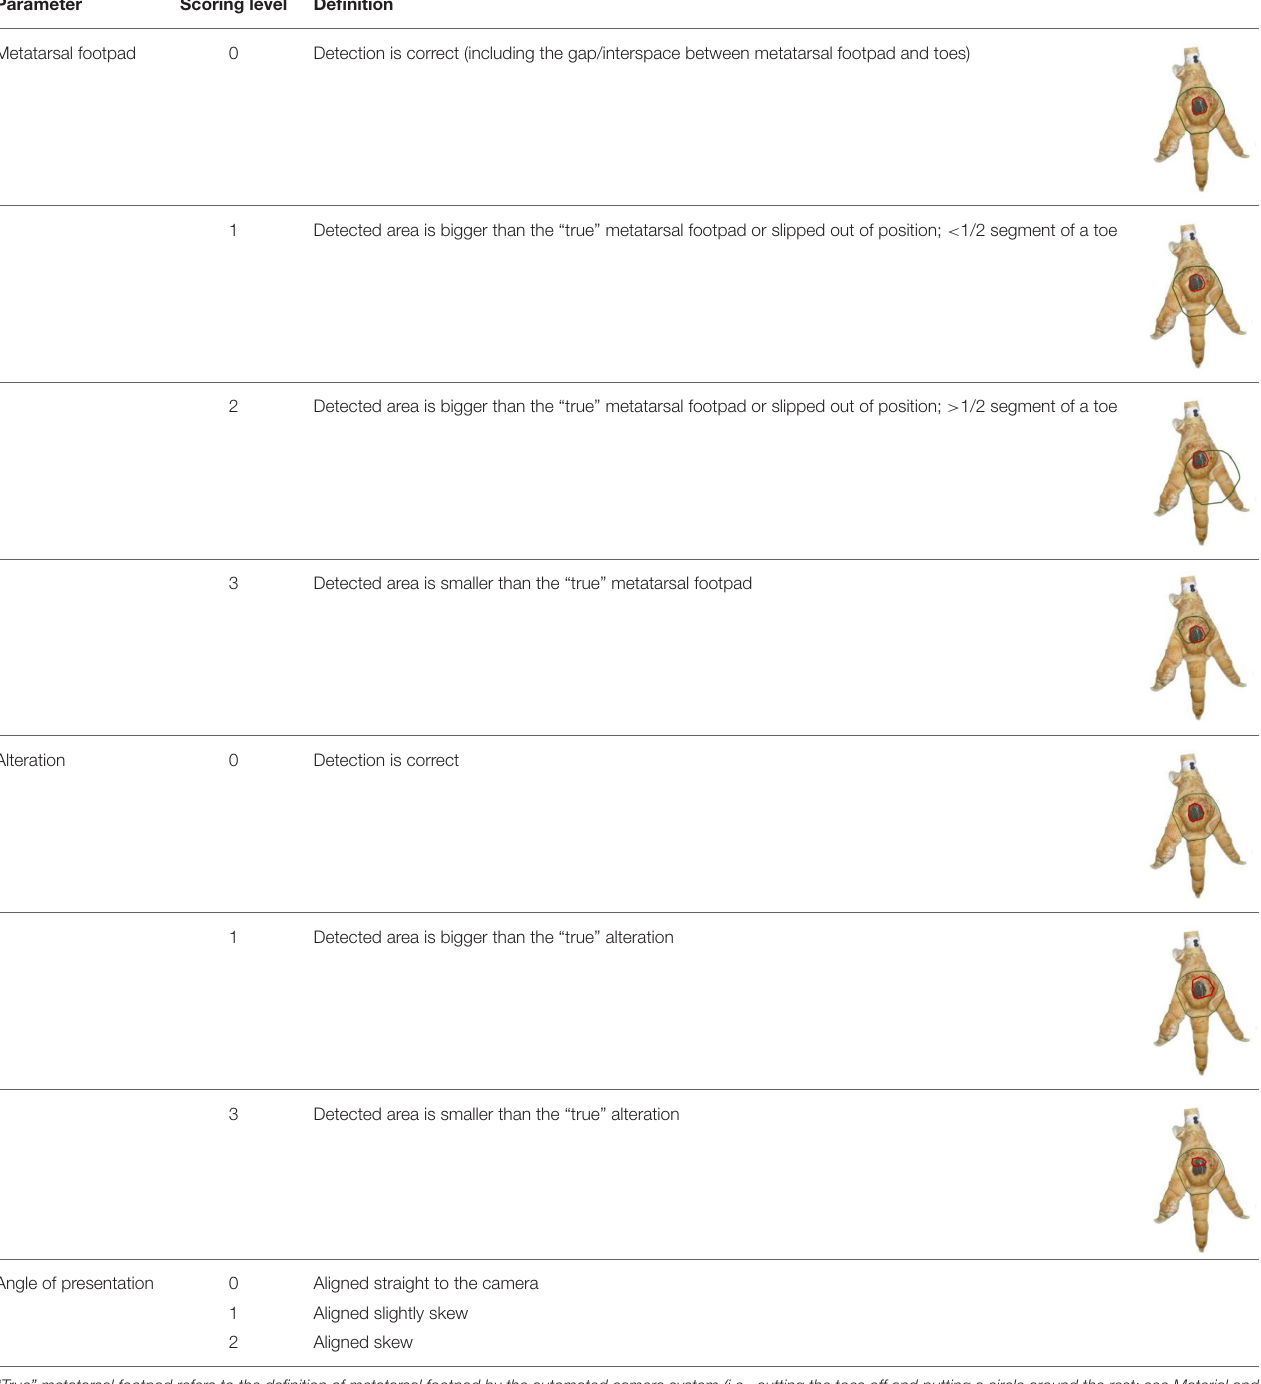
TABLE 2 | Scoring system to evaluate the accuracy of the automated camera system.